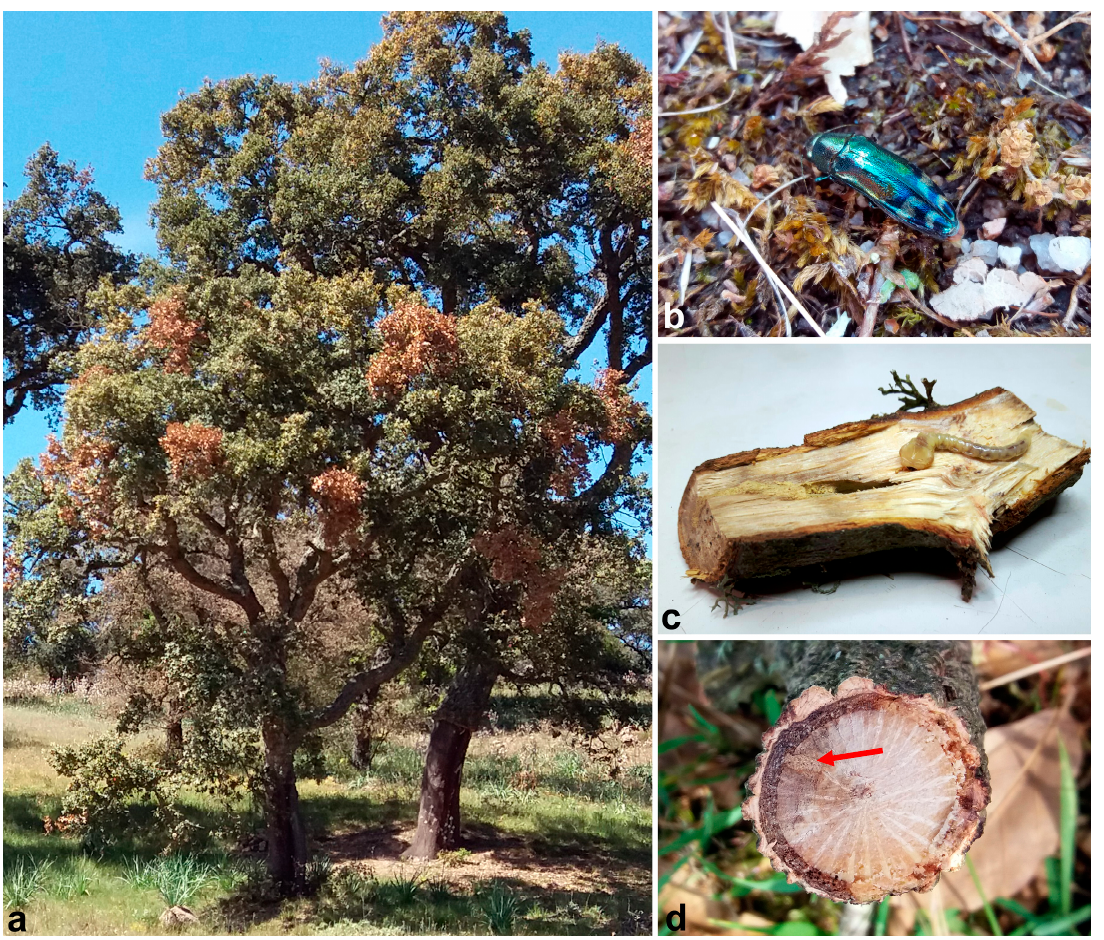
Figure 1. Cork oak tree showing multiple branch dieback symptoms ( a ), adult and larvae of Coraebus florentinus ( b and c ), and necrotic wood tissues surrounding the beetle gallery (red arrow) on a cork oak branch ( d ).